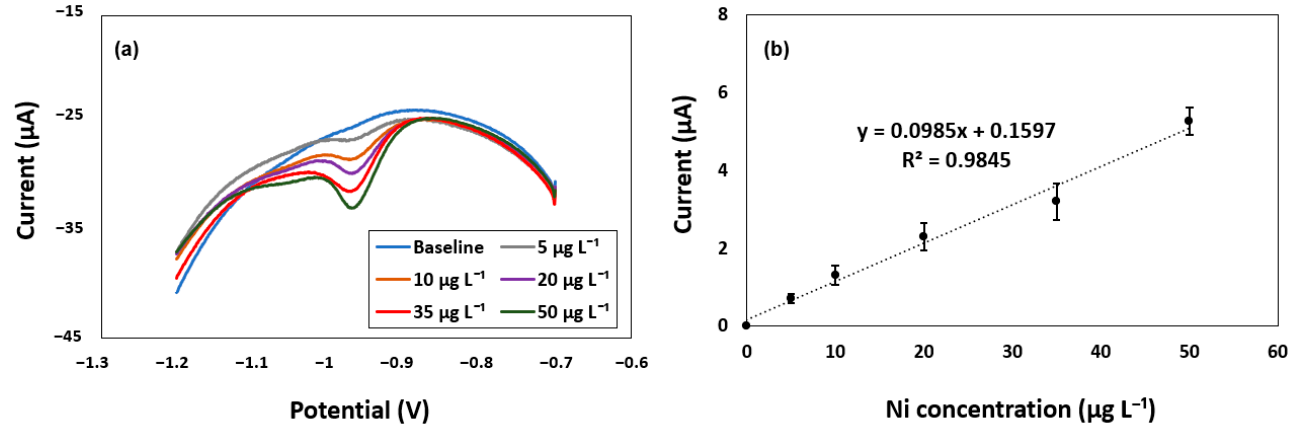
Figure 7. Characterization and evaluation of the Bi-chitosan sensor for Ni(II) detection in real natural water samples. ( a ) SWAdCSV with various Ni(II) concentrations (5–50 µ g L − 1 ) and ( b ) a corresponding calibration curve. Deposition time is 120 s with a deposition potential of − 0.9 V, frequency of 120 Hz, amplitude of 50 mV, and DMG concentration of 0.2 mM.